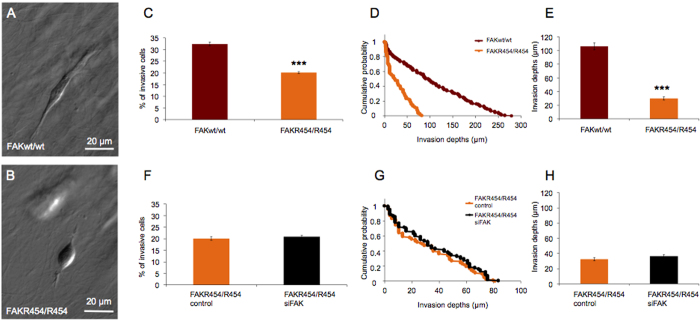
Impact of FAK kinase activity on matrix invasion of fibroblasts.Invasiveness of hTERT-immortalized FAKwt/wt and FAKR454/R454 cells was analyzed in the 3D extracellular matrix invasion assay. (A,B) Representative images of invading cells showing FAKwt/wt cells (A) at 122 μm invasion depth and FAKR454/R454 cells (B) at 39 μm invasion depth. (C) The percentage (mean ± SD) of invasive cells is significantly higher for FAKwt/wt compared to FAKR454/R454 cells. (D) Invasion profiles and (E) invasion depths are also altered. Average invasion depths of FAKwt/wt cells is significantly higher than that of FAKR454/R454 cells. (F–H) Effects of siRNA-mediated FAK-silencing (Supplementary Fig. S1 and Table S1) on invasiveness of FAKR454/R454 cells were investigated. Compared to controls, siFAK treatment does neither alter (F) the percentage (mean ± SD) of invasive FAKR454/R454 cells, nor (G) the invasion profiles or (H) the average invasion depths of cells. (n = 4, p*** < 0.001).